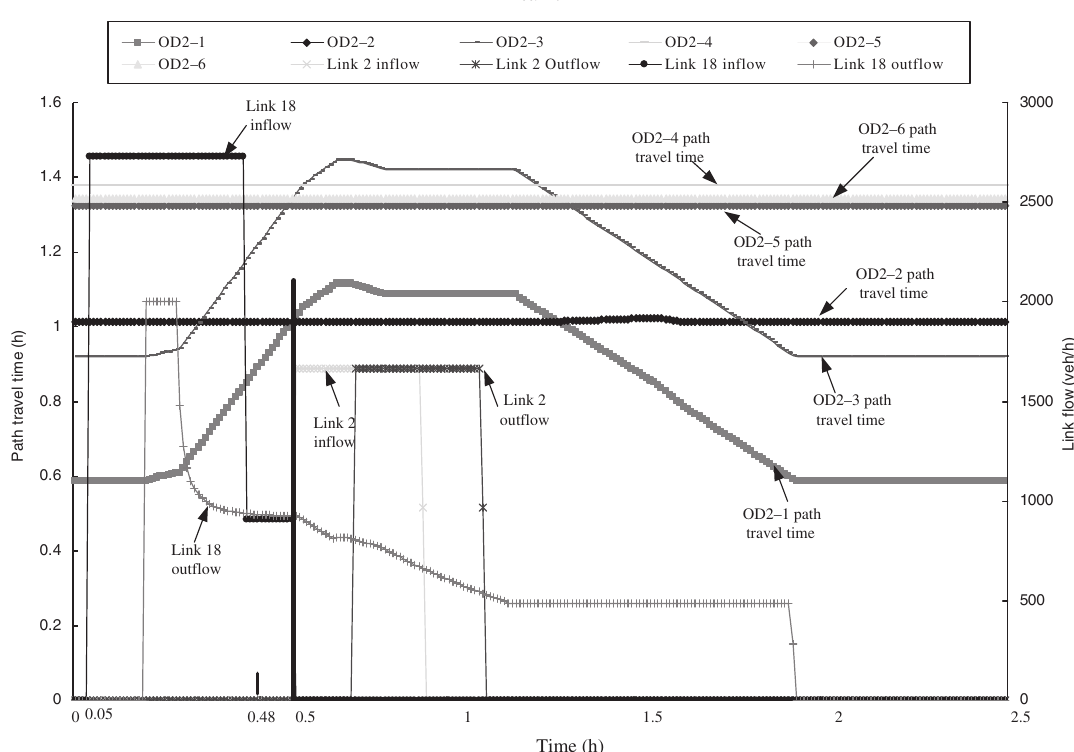
Fig. 3. The car flow and instantaneous travel time on Links 2 and 18